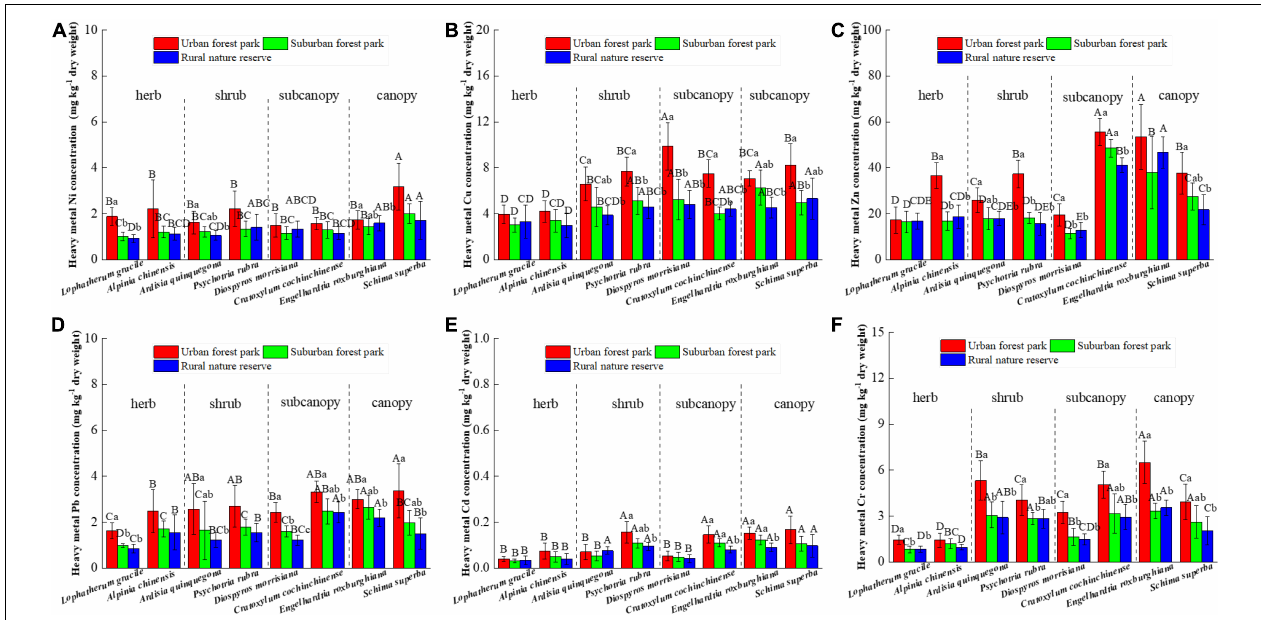
FIGURE 2 | Effects of growth environment on heavy metal (A) Ni, (B) Cu, (C) Zn, (D) Pb, (E) Cd, and (F) Cr concentrations of leaves of eight plant species. The lowercase letters reveal the significant differences ( P < 0.05 ) of the same species among different growth environments, and the capital letters reveal the significant differences ( P < 0.05 ) of different species in the same growth